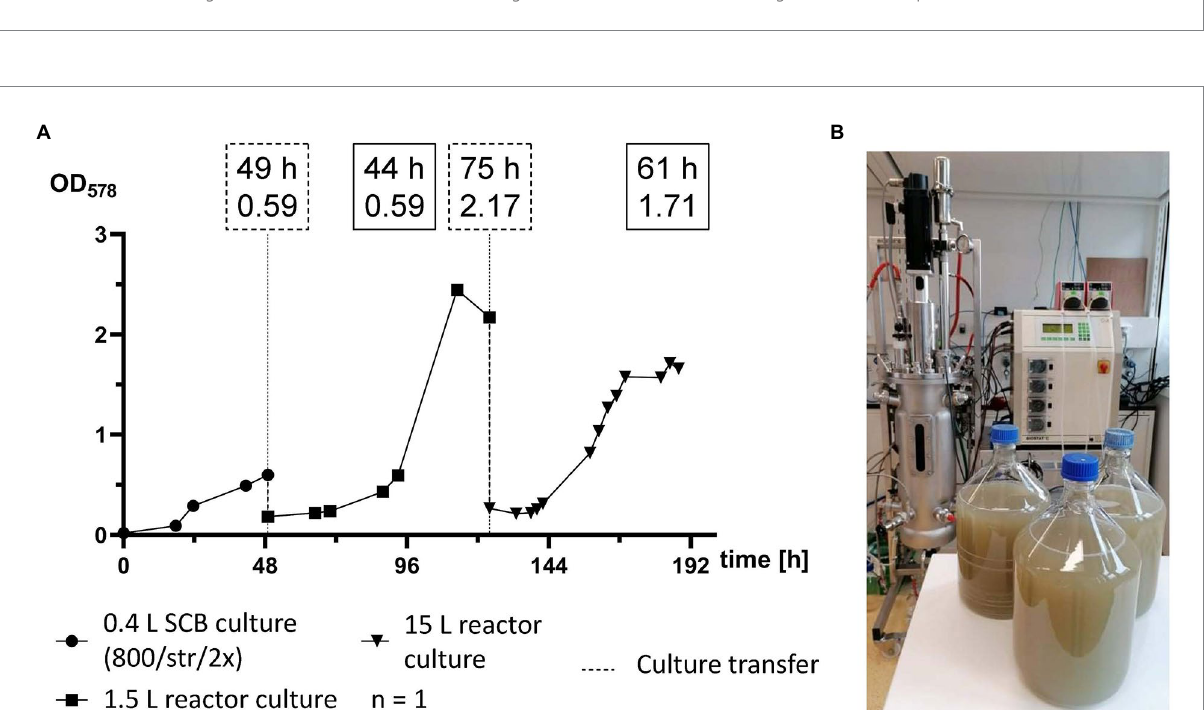
FIGURE 5 Scale-up of M . maripaludis toward a 15 L reactor culture. (A) OD 578 (left Y axis) measured over time in h for a single replicate subjected to the following cultivation methods: SCB cultivated at 1 bar H 2/ CO 2 twice (2×) a day and agitated by stirring at 800 rpm (0–49 h); 1.5 L reactor culture subjected to adaptation round setup (49–124 h); a 15 L reactor culture (124–188 h). Dotted line for culture transfer designates harvesting and inoculation procedures between the distinct groups. Dotted text boxes designate time (h) and OD of cultures during transfers. Solid text boxes designate time (h) and OD of crucial stages of culture growth. (B) Harvested biomass with the used Sautorius Biostat C